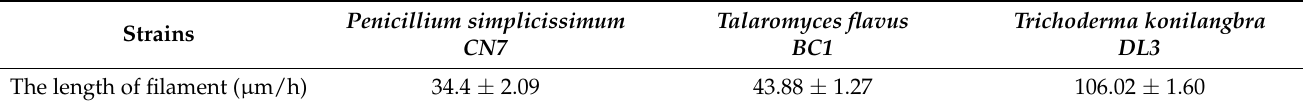
Figure 3. Morphology of mycelium of Penicillium simplicissimum CN7 , Talaromyces flavus BC1 , and Trichoderma konilangbra DL3 . Table 3. The filamentous propagation of fungal strains Penicillium simplicissimum CN7 , Talaromyces flavus BC1 , and Trichoderma konilangbra DL3 on PDA